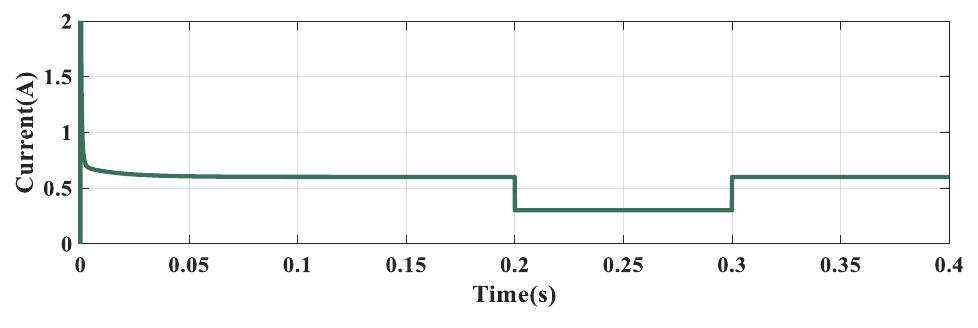
Figure 7. Study 1: load current.